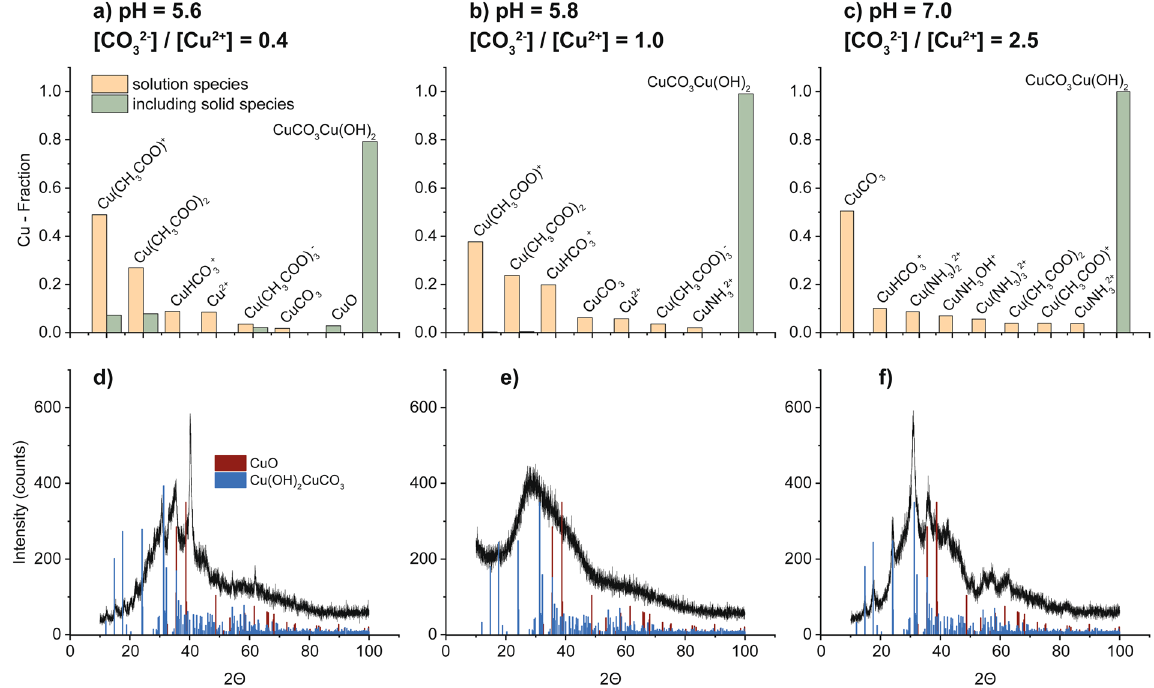
Figure 4. Theoretical fractions of Cu solution and precipitation species for different [CO 32 − ]/[Cu 2 + ] concentration ratios and pH’s of the mixed solution, as calculated including ( green ) and excluding precipitation species ( orange ). Predictions for ( a ) [CO 32 − ]/[Cu 2 + ] = 0.4 and pH = 5.6, ( b ) [CO 32 − ]/[Cu 2 + ] = 1.0 and pH = 5.8 and ( c ) [CO 32 − ]/[Cu 2 + ] = 2.5 and pH = 7.0. The respective XRD patterns of the experimentally collected shown in ( d – f ) respectively including reference pattern for CuO (red) 33 and malachite (blue) 32